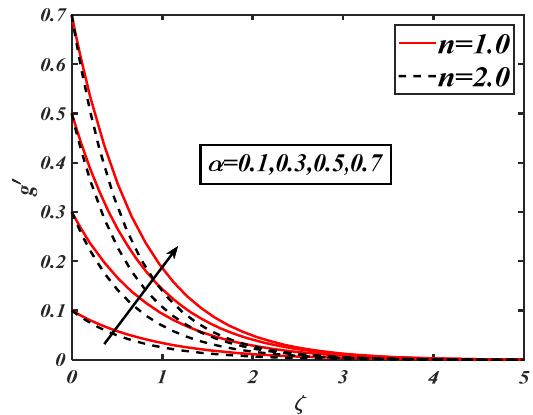
α Figure 10. illustration against g Figure 10. α illustration against g (cid:48)